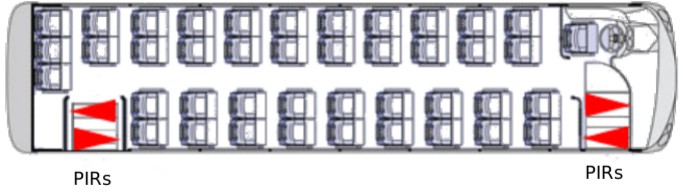
Figure 3. Sensor application in a bus. PIRs, passive infrared